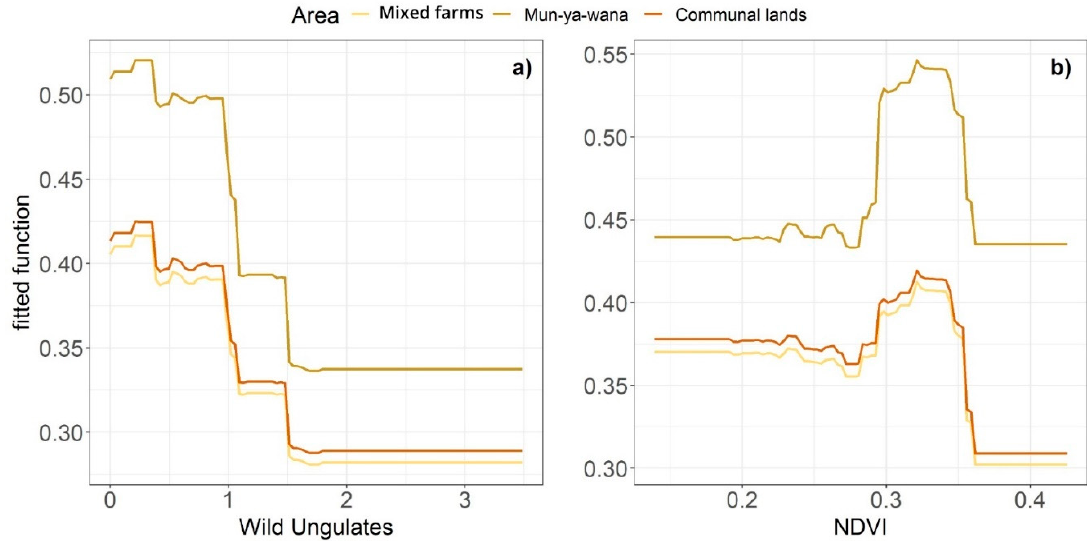
Figure 5. Interaction between area typology and ( a ) wild ungulates ( b ) NDVI. Each line represents the variation of small- rodent abundance in the respective area (see color legend).